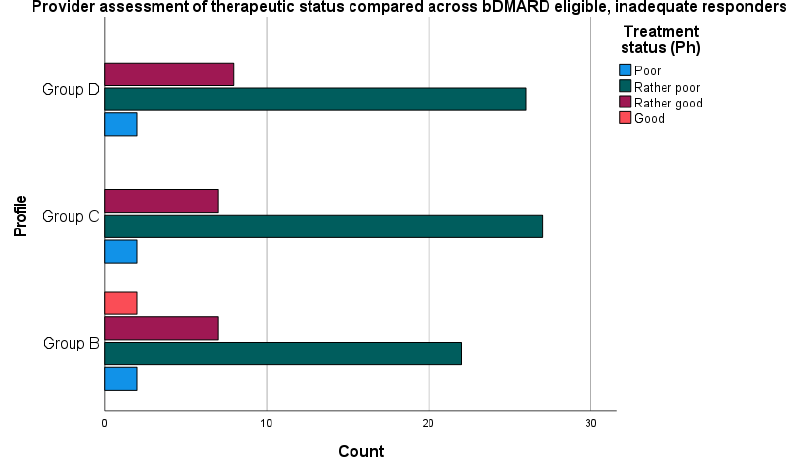
Figure 2. Overview of specialist assessment of therapeutic status according to the question stem,